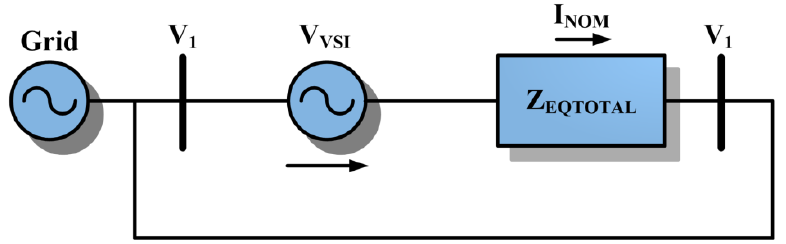
Figure 5. Equivalent system to Kirchhoff’s voltage law analysis.